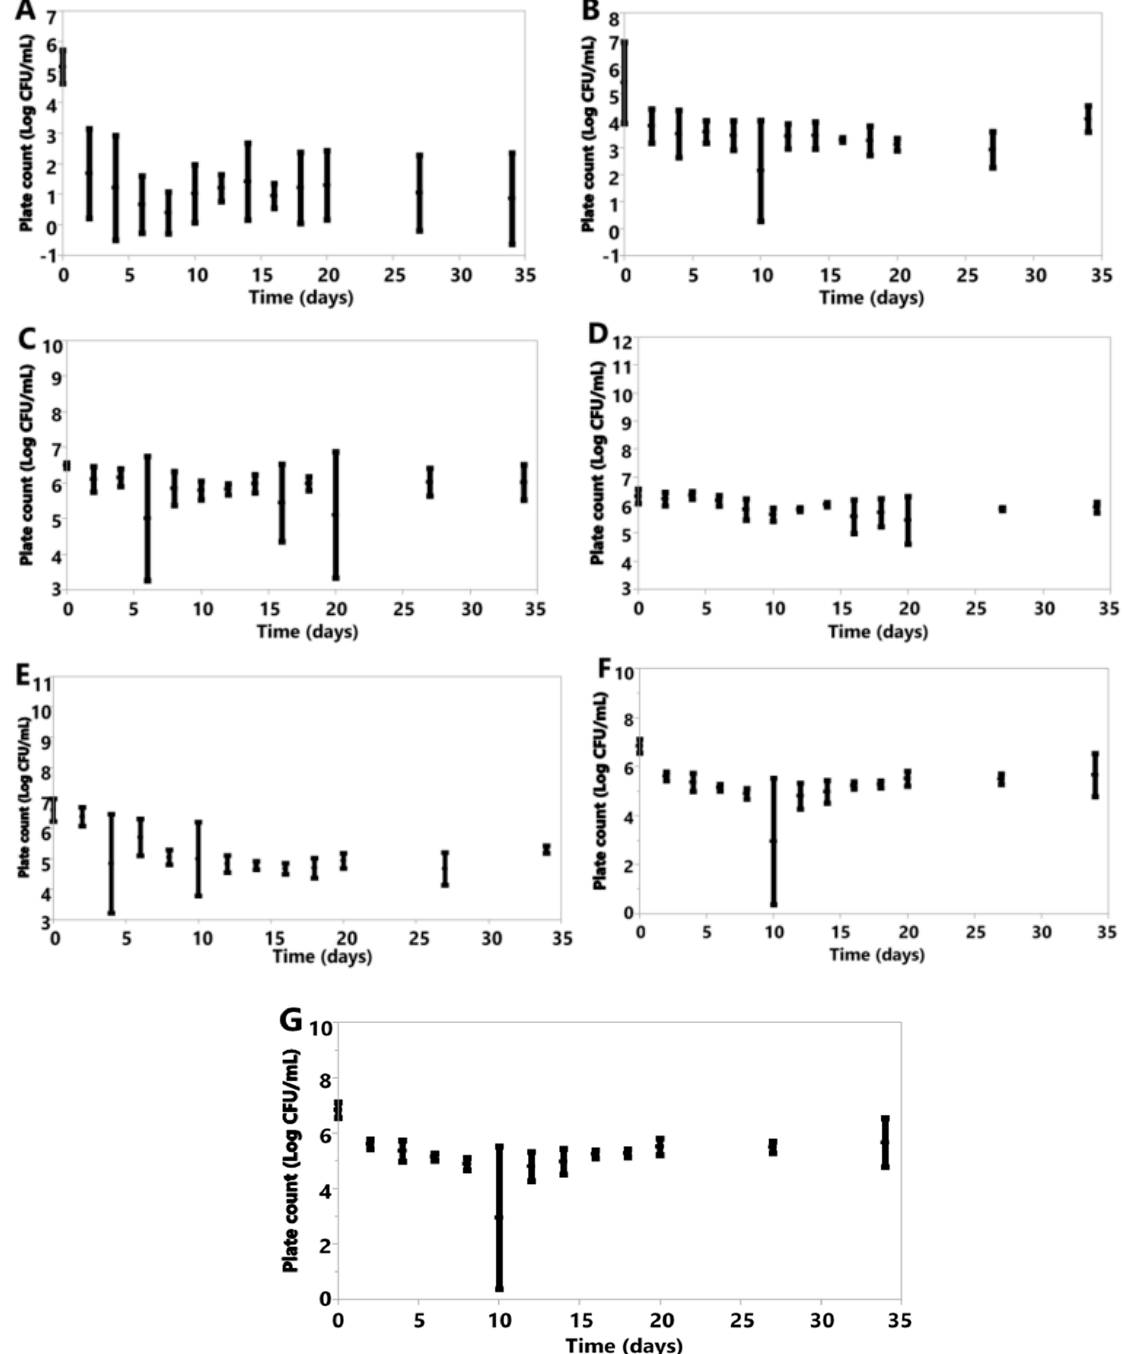
Figure 5. Plotted values represent means, and error bars represent standard deviations for A. pullulans ( A ), B. bruxellensis ( B ), B. claussenii ( C ), D. anomala ( D ), K. lactis ( E ), K. marxianus ( F ), M. genevensis ( G ) under anoxic conditions. All were calculated from three replicates for each species, except M. genevensis , which only had two viable replications.